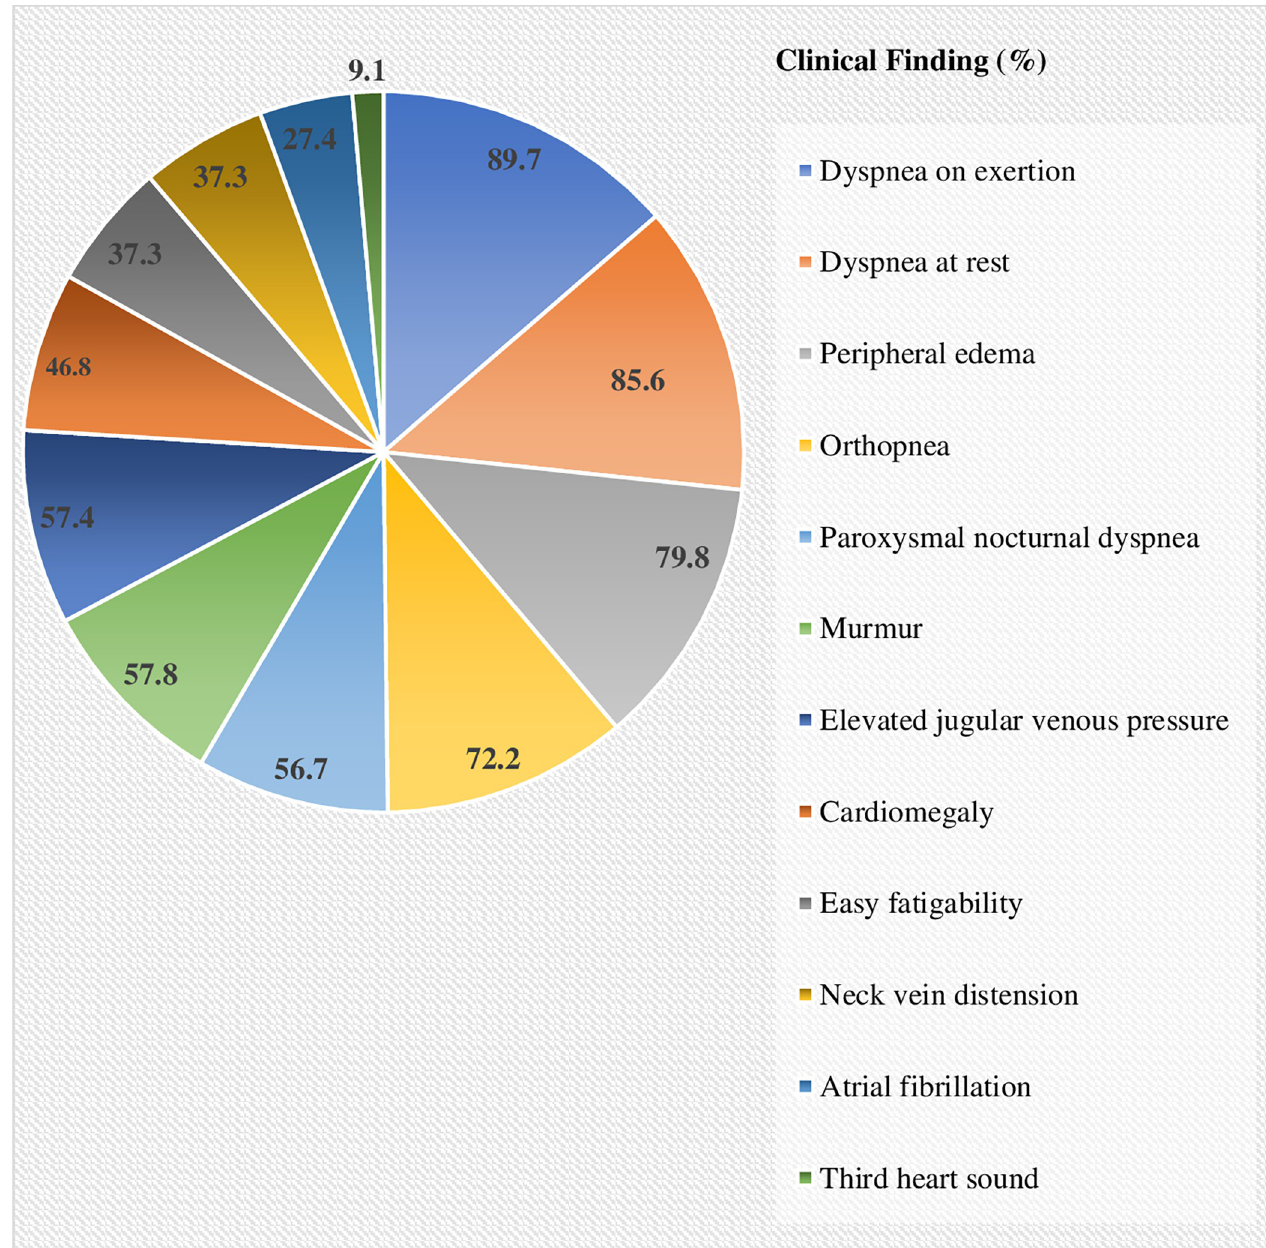
Fig 1. Clinical findings of HF patients admitted at UOGCSH medical ward, 2020 (N = 263). https://doi.org/10.1371/journal.pone.0270809.g001 counterparts. In contrast to this, the study showed that for every unit increase in the admission respiratory rate and serum potassium there is 0.242 and 1.525 decrease in the LOS, respec- tively. Comparing to patients who were admitted without third heart sound, patients presented with third heart sound had 4.118 times lower LOS. Additionally, comparing to other causes of AHF patients who were admitted because of hypertensive heart disease had 6.349 times lower LOS.